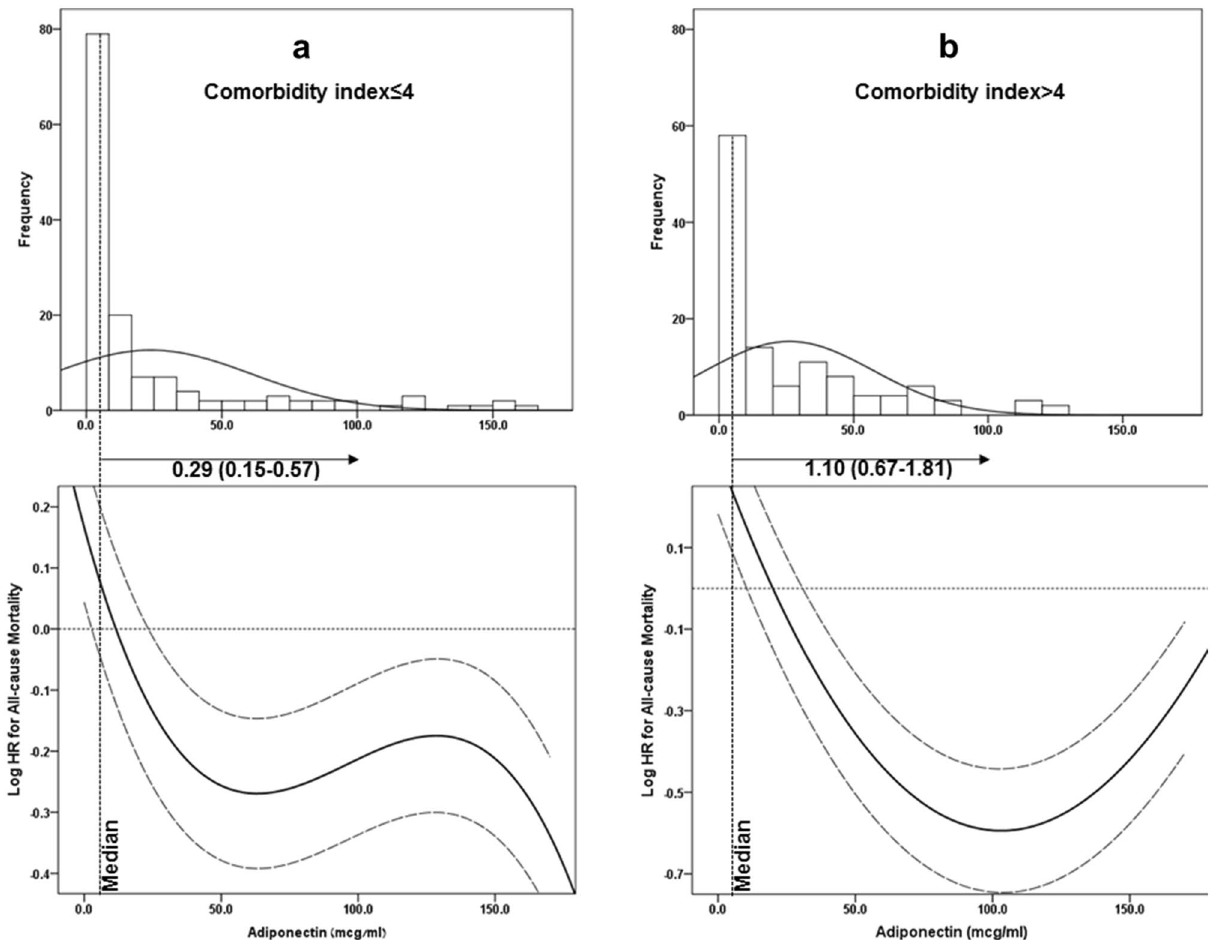
Figure 4. Histograms and multivariable-adjusted spline curves of adiponectin’s association with all-cause mortality presented as log hazard ratios (solid lines) and 95% confidence interval (dashed lines) according to multivariable Cox regression models: ( a ), in MHD patients with CI ≤ 4; ( b ) in MHD patients with CI > 4. The models are plotted as restricted cubic splines with three internal knots. Multivariable models were adjusted for age, gender, DM status, co-morbidity index, smoking, residual renal function, dialysis vintage, Kt/V and FMI. Abbreviations: MHD, maintenance hemodialysis; CI, comorbidity index; FMI, fat mass index; DM, diabetes